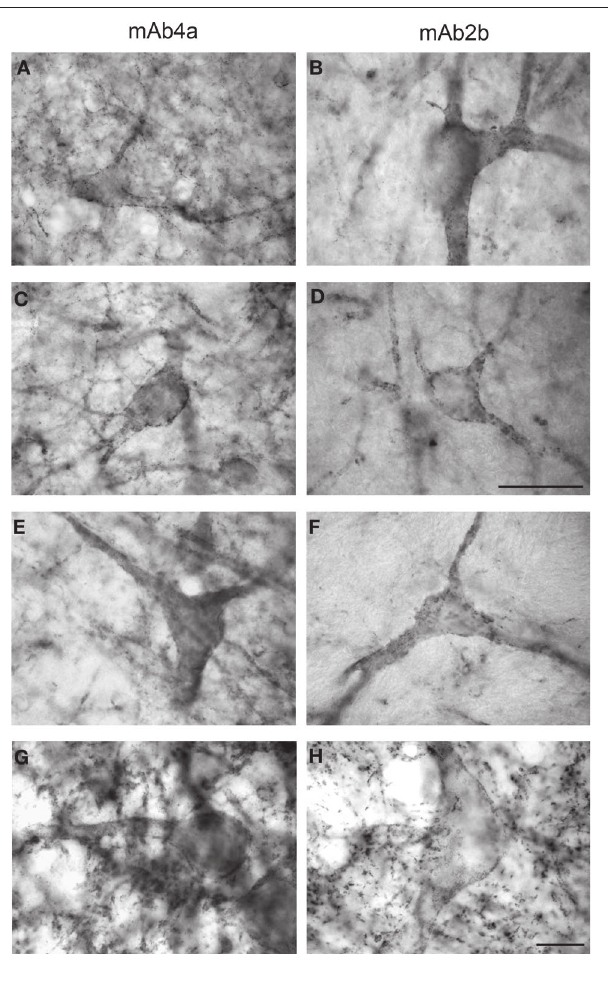
FIGURE 2 | Glycine receptor labeling on neurons in the human midbrain and medulla oblongata visualized by DAB staining of adjacent sections using monoclonal antibody mAb4a (A,C,E,G) and monoclonal antibody mAb2b (B,D,F,H). (A,B) Neurons in the periaqueductal grey area of the midbrain showing high levels of punctate GlyR-IR along their soma and processes, revealing similar IR patterns using mAb4a (A) or mAb2b (B) . (C,D) Neurons in the superior colliculus of the midbrain immunoreactive for mAb4a (C) and mAb2b (D) demonstrating GlyR-IR outlining the membranes of soma and processes. (E,F) Neurons in the magnocellular region of the reticular formation in the medulla oblongata immunoreactive for mAb4a (E) and mAb2b (F) revealing GlyR-IR along the neuronal soma and processes. (G,H) High levels of immunoreactive GlyR are present on neurons in the hypoglossal nucleus of the upper medulla stained for mAb4a (G) and mAb2b (H) . Scale bar = 50 µm in (D) applies to (C–F) ; 10 µm in H [applies to (A,B,G,H) ]. staining surrounded by a more densely staining background which resembled the striosome and matrix compartmental organization of the striatum ( Figures 1G,H